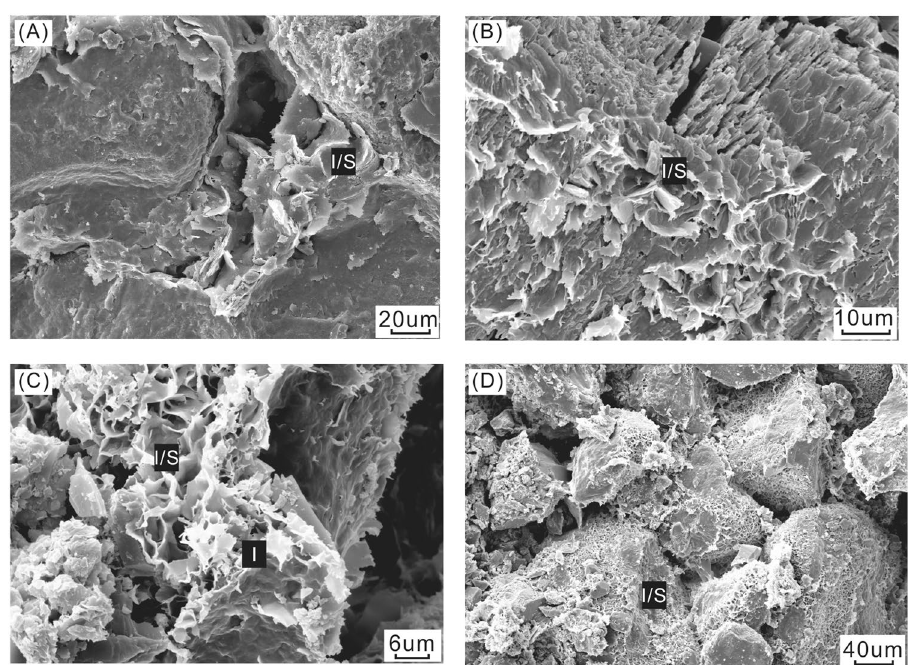
Figure 4. Representative scanning electron microscope (SEM) images of illitic clays in the Silurian bituminous sandstone 13 . ( A ) Flaky ordered I/S particles in YM35-1. I/S particles contain small proportions of expandable smectite layers (interstratified ratio (IR) = 5%); ( B ) Flaky and filamentous ordered I/S particles in H6. I/S particles contain high proportions of expandable smectite layers (IR = 20%). ( C ) Honeycomb I/S and filamentous illites (I) in TZ67. I/S particles contain high proportions of expandable smectite layers (IR = 30%); ( D ) Honeycomb ordered I/S particles in TZ67. I/S particles contain high proportions of expandable smectite layers (IR =